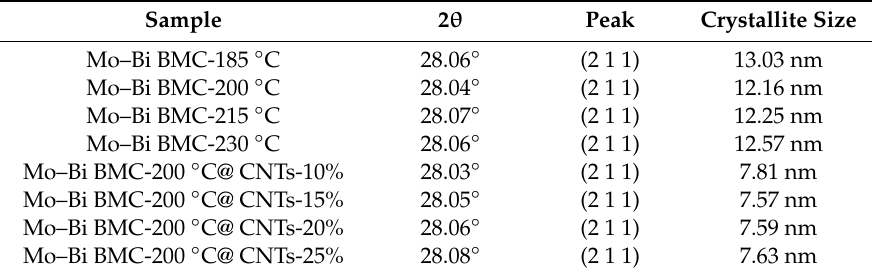
Table 1. Crystallite size of the catalysts calculated using the XRD data.